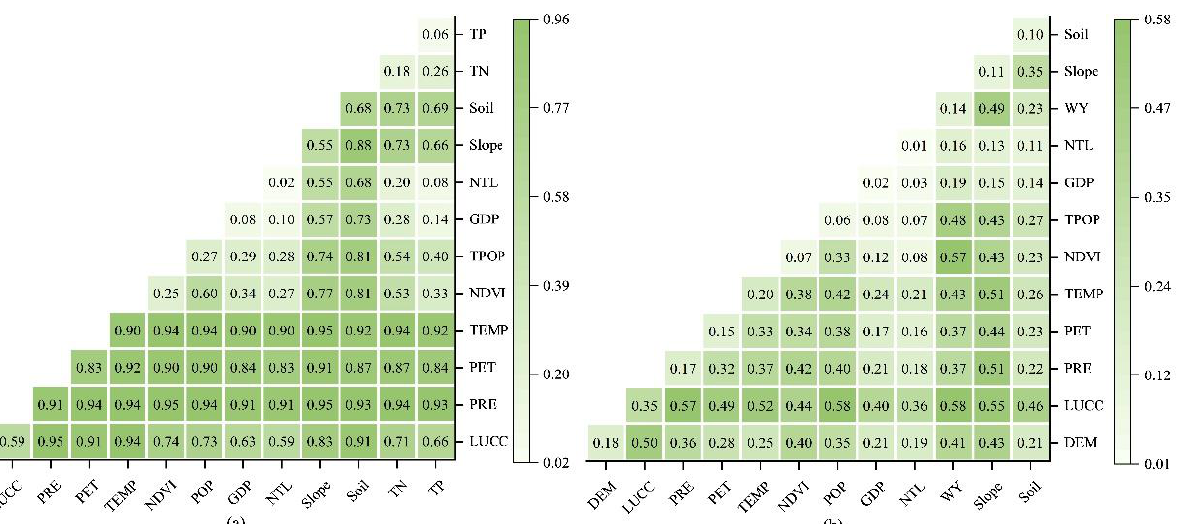
Figure 9. Nitrogen export loads ( a ) and phosphorus export loads ( b ) from the Ebinur Lake Basin